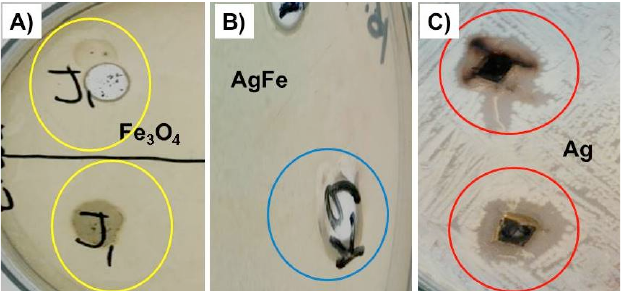
Fig. 4. Effect of antibacterial activity of Fe 3 O 4 (A), AgFe (B) and Ag (C) nanoparticles to the E.coli bacteria cell